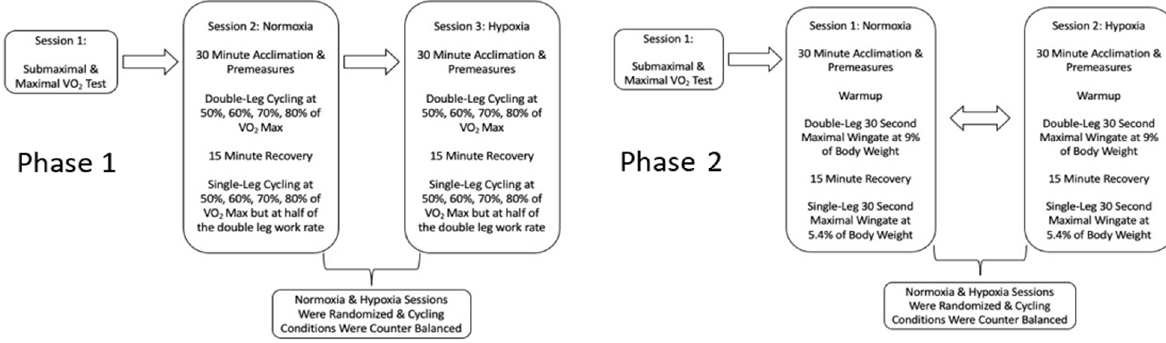
Figure 1. Timeline for phase 1 and